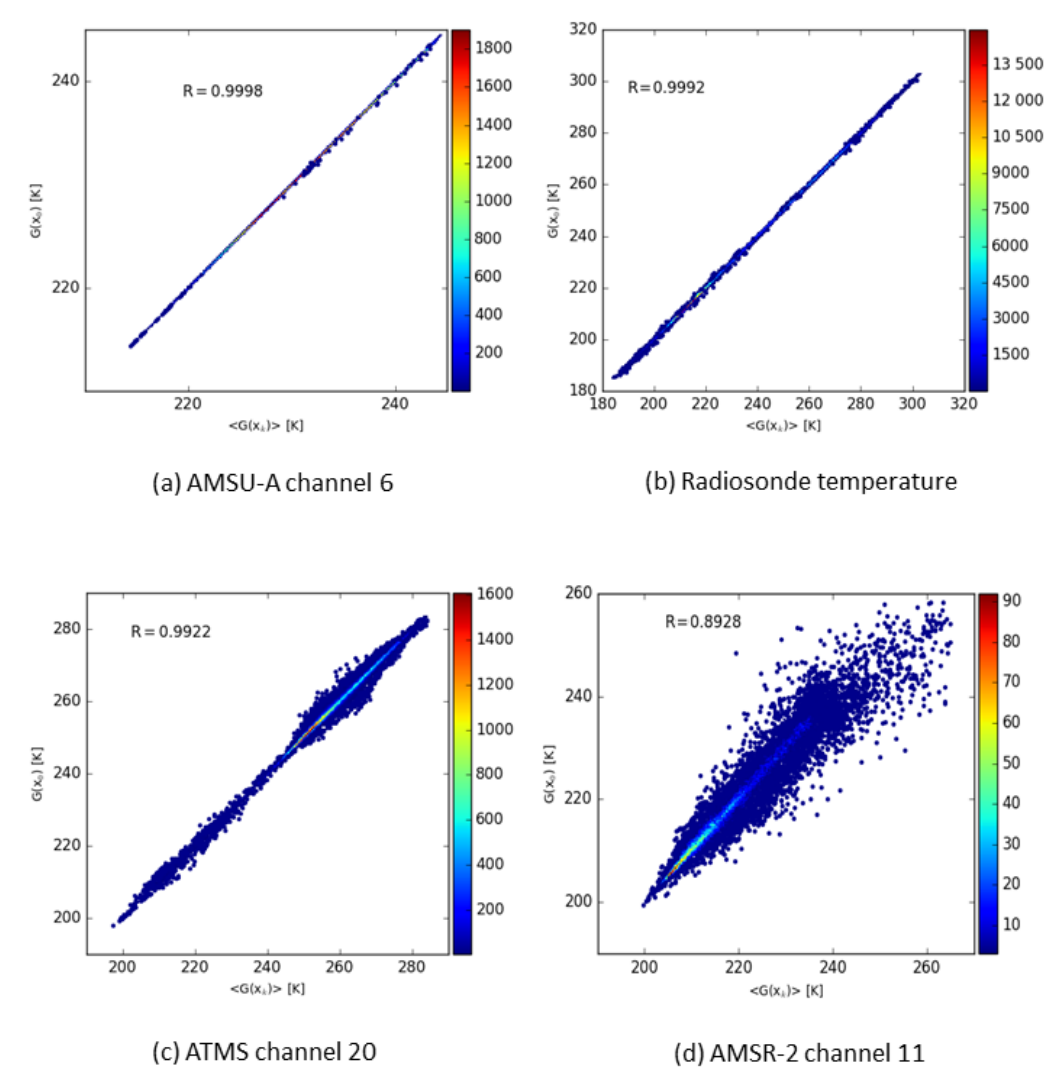
Figure 2. Ensemble mean G(x) ( x axis) against control member G(x) for (a) AMSU-A channel 6 in clear-sky locations, (b) radiosonde temperature, (c) ATMS channel 20 (clear-sky) and (d) ASMR-2 channel 11 observations